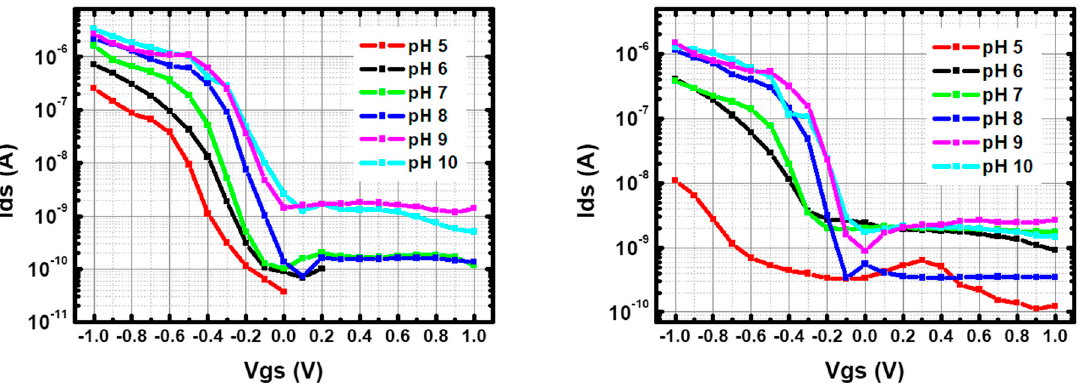
di ff erent pH from pH 10 to pH 4. V ds is fi xed at +0.8 V. different pH from pH 10 to pH 4. V ds is fixed at +0.8 V.